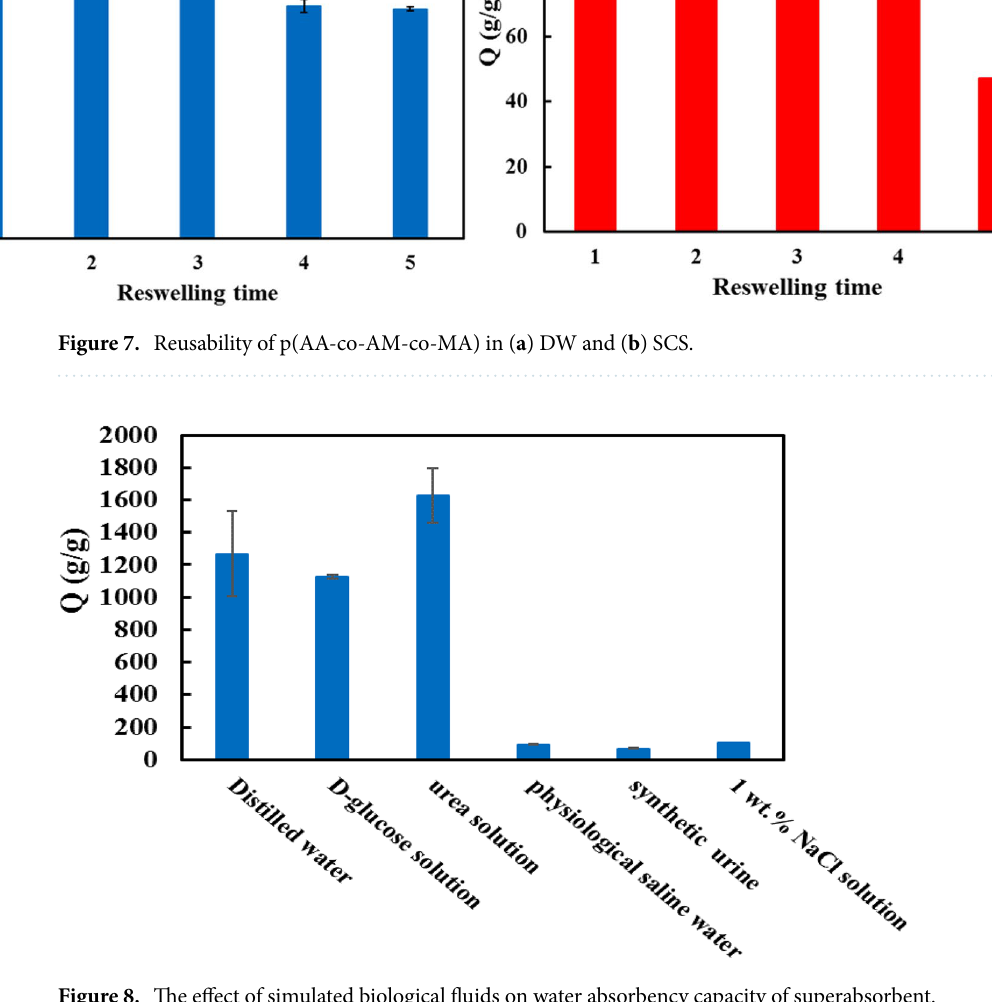
Figure 8. The effect of simulated biological fluids on water absorbency capacity of